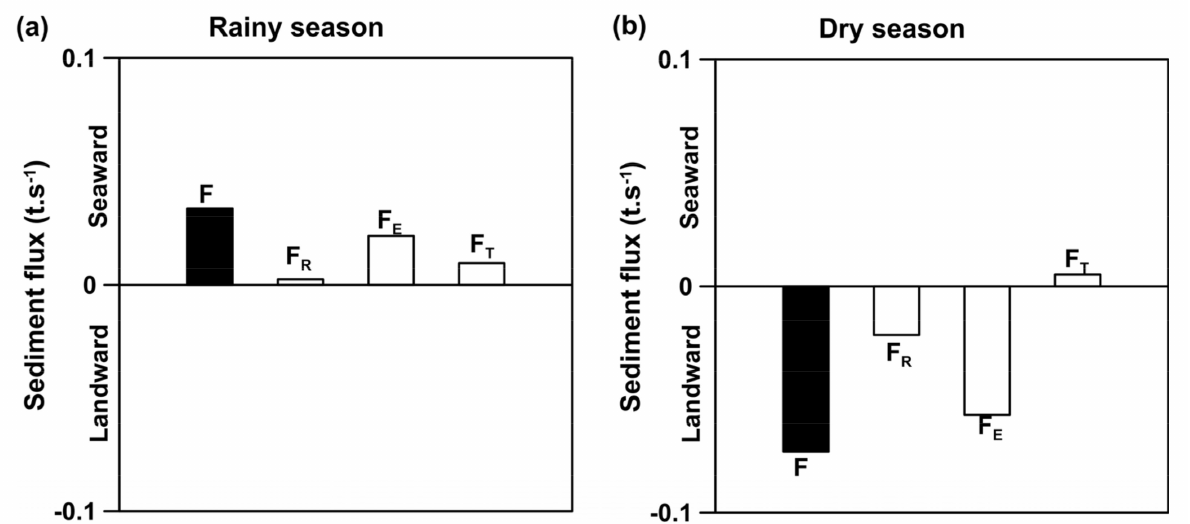
Figure 7. Sediment flux decomposition for Gurupi estuary during the rainy ( a ) and dry ( b ) seasons. The first column (black) represents the total sediment flux (F). F R , F E , and F T represent river flux, estuarine exchange, and tidal residual flux,